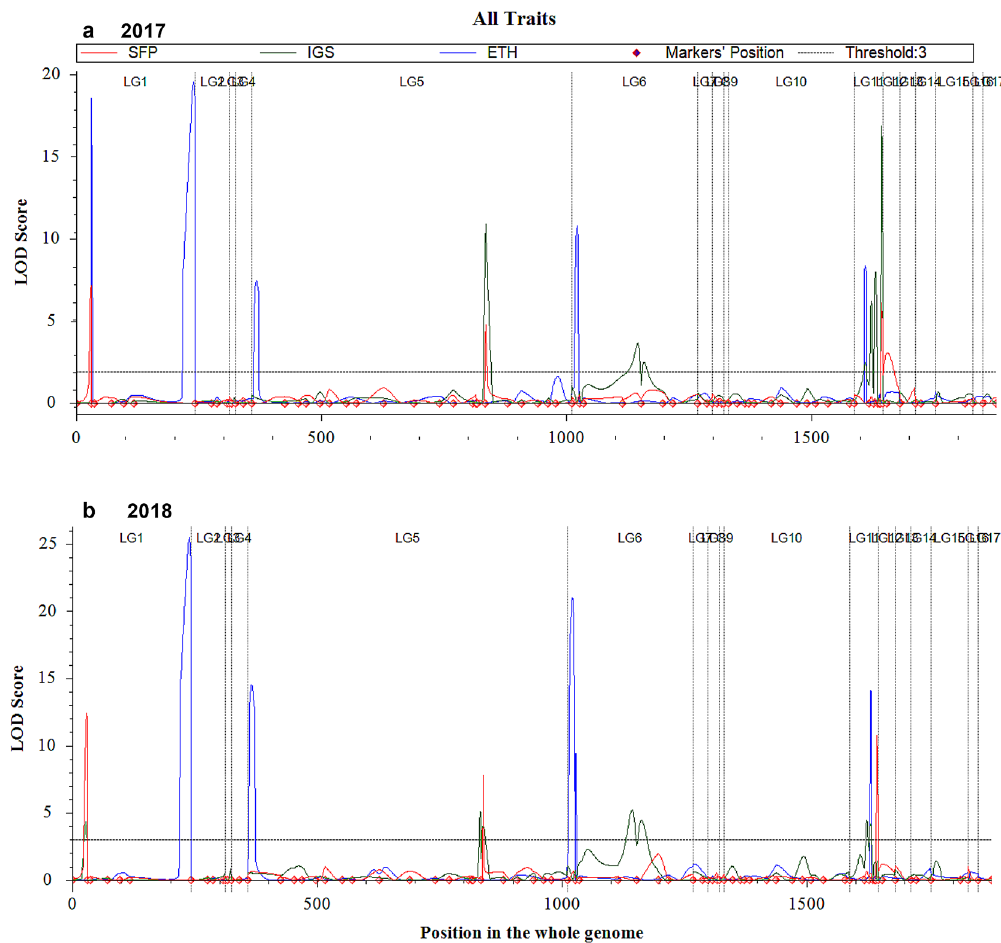
Figure 3. One-dimensional scanning of whole genome for identification of QTLs associated with spikelet fertility percentage (SFP), inter-grain space (IGS) and ethylene production (ETH) in kharif 2017 and kharif 2018, detected at threshold LOD score 3 using QTL ICI mapping V4.1 software. Graph shows identified QTL peaks on linkage groups. Fourteen peaks corresponding to fourteen QTLs were identified in kharif 2017 on chromosome 1 (LG1), chromosome 3 (LG5), chromosome 4 (LG6), chromosome 6 (LG11) and chromosome 8 (LG12). Fifteen peaks corresponding to fifteen QTLs were identified in kharif 2018 on chromosome 1 (LG1), chromosome 3 (LG5), chromosome 4 (LG6) and chromosome 6 (LG11). LG—Linkage